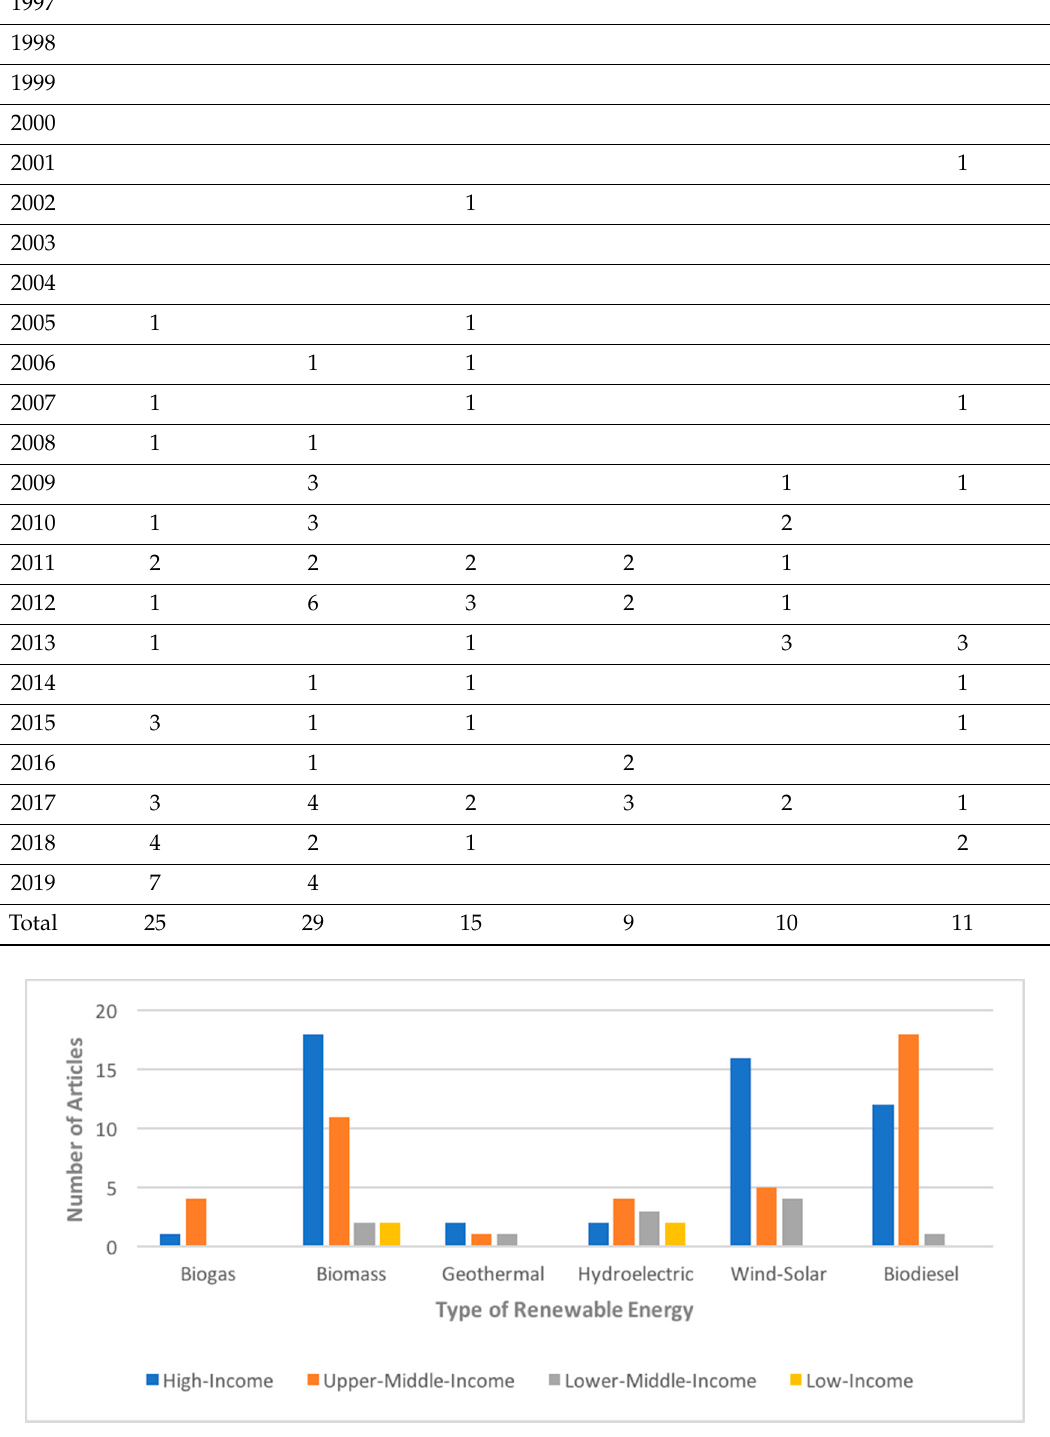
Figure 7. Type of renewable energies by level of countries’ development analyzed in the research sample.